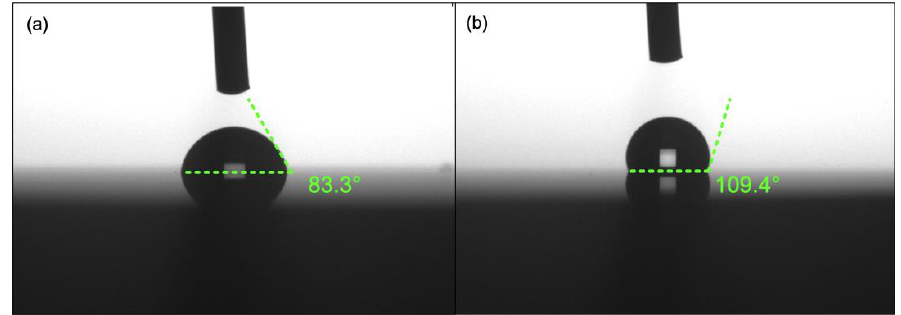
Figure 5. Water contact angle measurement of solidified coatings from ( a ) As-synthesized pre-polymer sol; ( b ) Sol A.